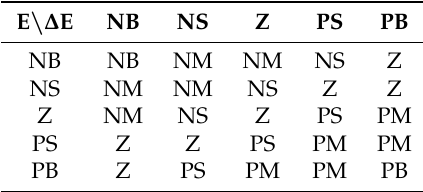
Table 1. FLC linguistic